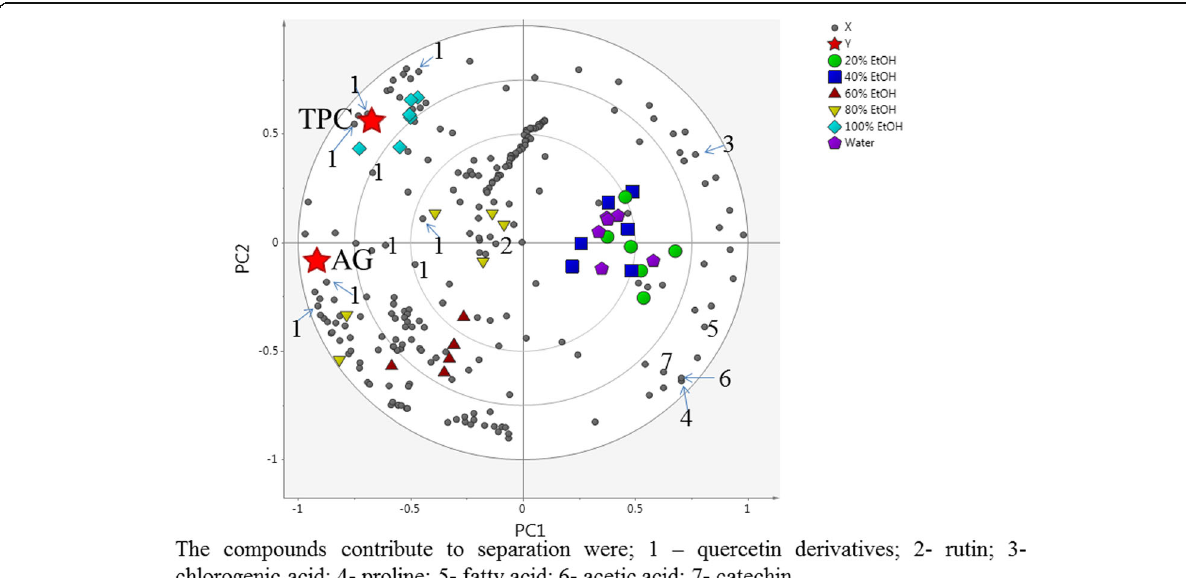
Fig. 4 The biplot obtained from PLS describing the variations between the different EtOH:water extracts of C. caudatus and the correlation between the metabolites in the extracts with TPC and α -glucosidase inhibitory activity. The following compounds contribute to the separation: 1 – quercetin derivatives; 2 - rutin; 3 - chlorogenic acid; 4 - proline; 5 - fatty acid; 6 - acetic acid; 7 - catechin